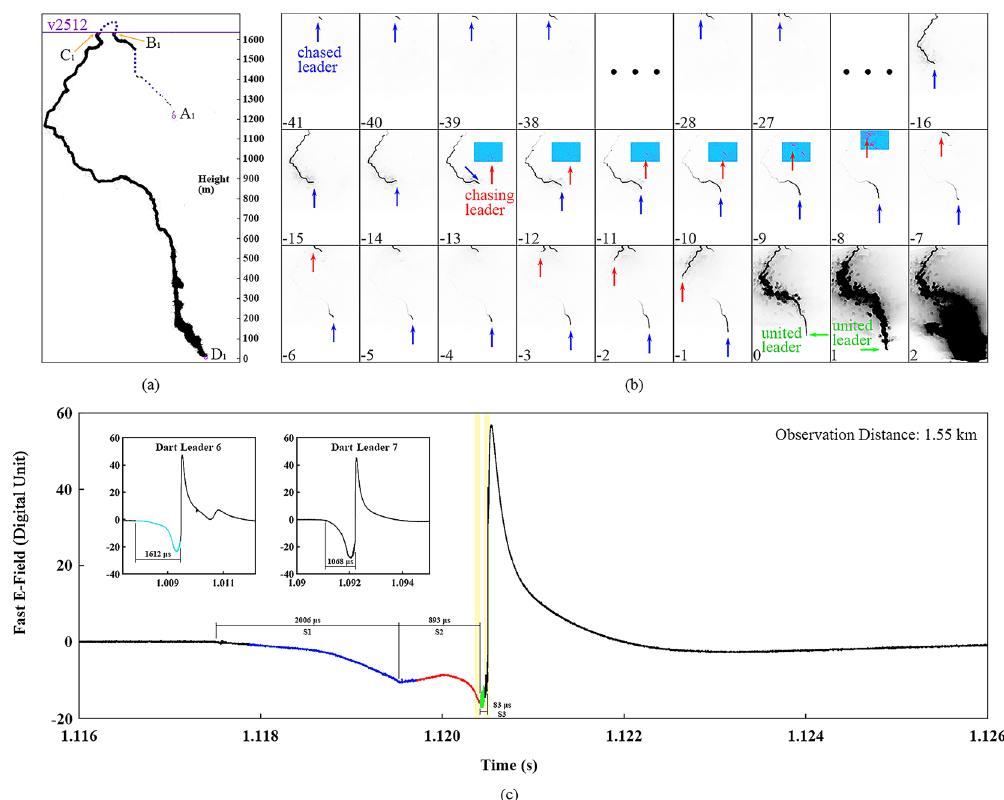
Figure 1. Optical recordings and corresponding electric field signatures of the leader-chasing behavior in Case I. ( a ) A processed frame showing the path for the leaders. The purple line indicates the upper boundary of the high-speed camera’s FOV, and the purple dotted line is the speculative channel structure. ( b ) A sequence of cropped high-speed frames showing the leader-chasing behavior, with background removed, intensity inverted, and contrast enhanced. The arrows with different colors indicate the position of each leader’s head. Some areas in Frames − 13 to − 7 were colored with contrast further enhanced. ( c ) Corresponding electric field signature with two insets showing